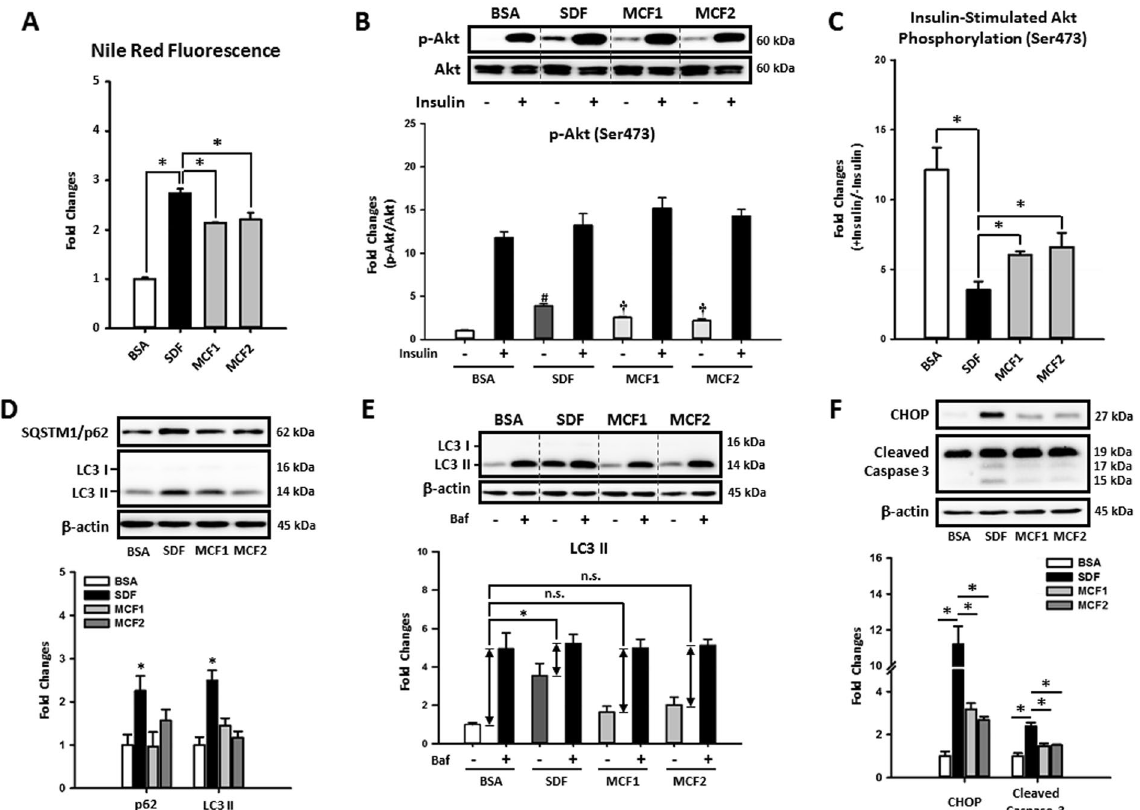
Figure 3. Increasing MCFA ratio attenuated LCFAs-induced fat accumulation, insulin resistance, autophagy impairment, ER stress, and apoptosis in HepG2 cells. To investigate whether MCFAs can directly exert their protective effects in hepatic cells, the fat accumulation, insulin resistance, autophagy impairment, ER stress, and apoptosis were evaluated in fat-loaded HepG2 cells. For intracellular lipid quantification, 48-hour fat-loaded cells were fixed then stained with Nile Red and Hoechst 33342 ( A ). For the insulin sensitivity test, cells were incubated with 100 nM insulin for an additional 10 min after a 48-hour fatty acid treatment. Representative immunoblots and densitometric quantification of phospho-Akt (Ser473) ( B ), and the calculated insulin- stimulated Akt phosphorylation fold change results ( C ) are presented. Representative SQSTM1/p62 and LC3 immunoblots and densitometric results show that increasing MCFA/LCFA ratio protected HepG2 cells against LCFA-induced autophagy impairment ( D ). Autophagic flux changes were also confirmed by analyzing Bafilomycin A1 (50 nM, 3 hours)-induced LC3 II protein accumulation in BSA or fatty acid-treated HepG2 cells ( E ). Western blotting results of CHOP and cleaved caspase 3 show that MCFAs also attenuated LCFAs-induced ER stress and apoptosis in HepG2 cells ( F ). For densitometric analyses of Western blotting data, β -actin or total Akt (for Akt phosphorylation analysis) were used as the loading control. Values are mean ± SEM (n = 3). * , # (vs. BSA treated cells without insulin stimulation), and † (vs. SDF-treated cells without insulin stimulation) indicate statistical significance, P < 0.05. n.s.: no significant difference. SDF: standard fat loading mixture (0.4 mM PA + 0.4 mM OA); MCF1: MCFA-containing fat mixture 1 (0.4 mM PA + 0.2 mM OA + 0.2 mM CA); MCF2: MCFA-containing fat mixture 2 (0.4 mM PA + 0.2 mM OA + 0.2 mM LA); Baf: Bafilomycin A1.